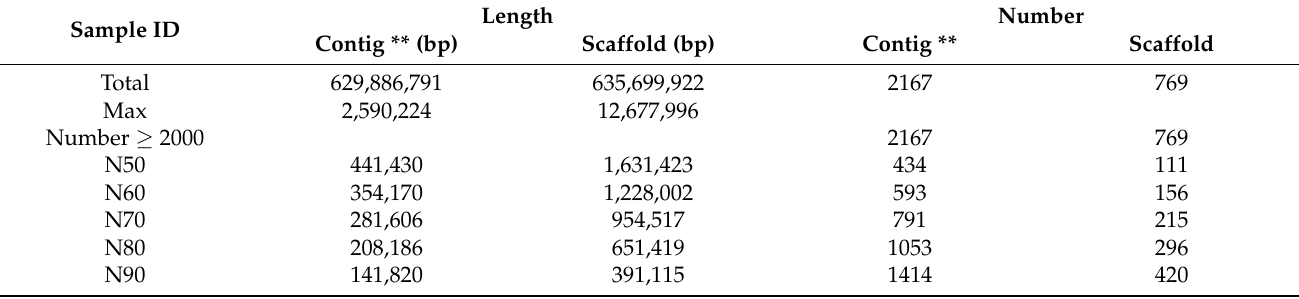
Table 3. Summary of the final genome assembly of C. roscoffensis .